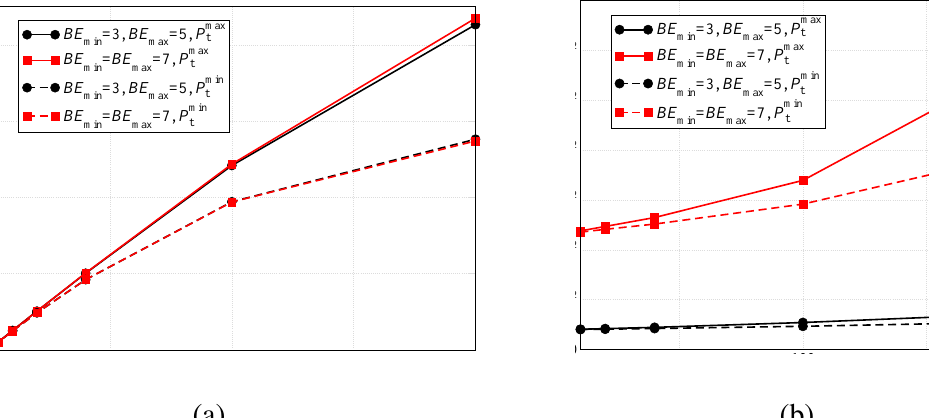
Figure 7. (a) Network transmission rate and (b) delay, as functions of the total offered traffic load ( Ng ), in the presence of (i) default backoff exponent, i.e., BE and (ii) modified backoff exponent, i.e., BE powers are considered. The allocated transmit power is the same at each